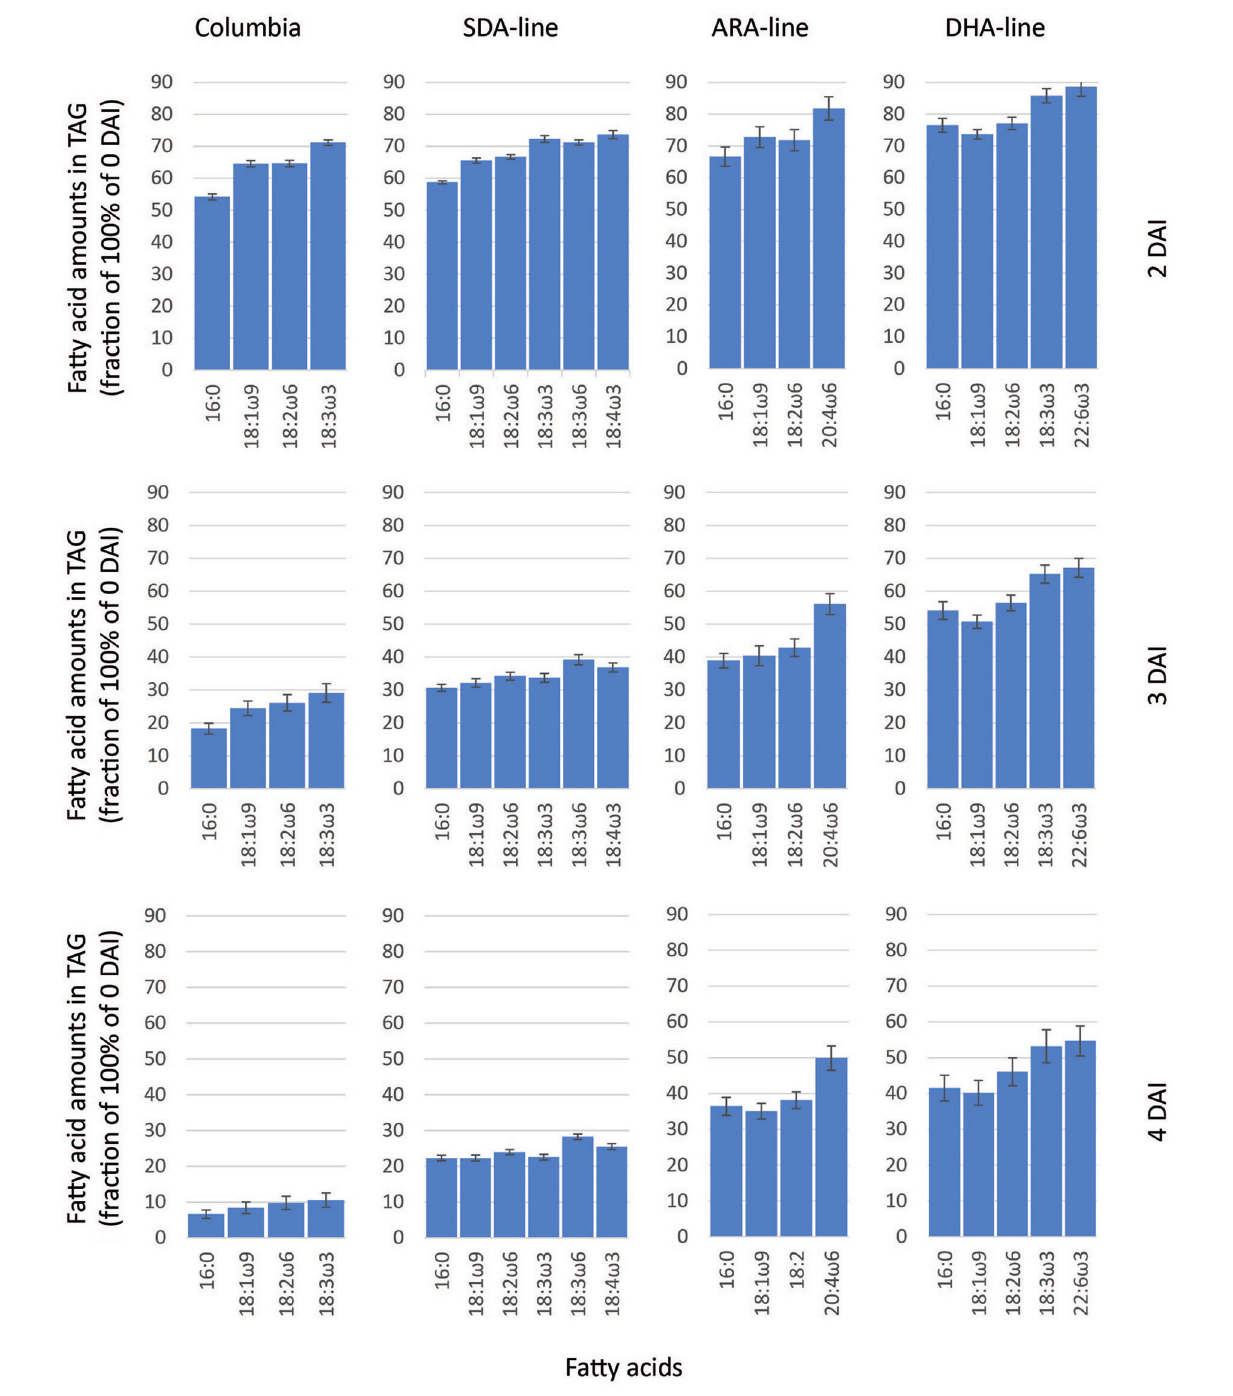
ARA. Our initial results showed reduced total TAG utilization in ARA-line at 4 DAI compared to MC49 parent line (data not shown). The MC49 was not included in the following